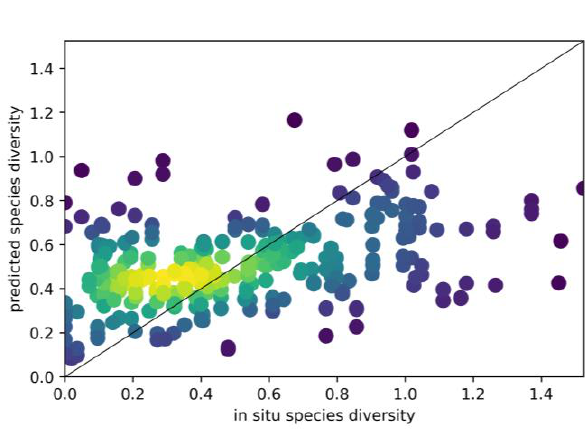
Figure 9: Scatter plot of predicted vs. in situ species diversity in forests, given by Shannon